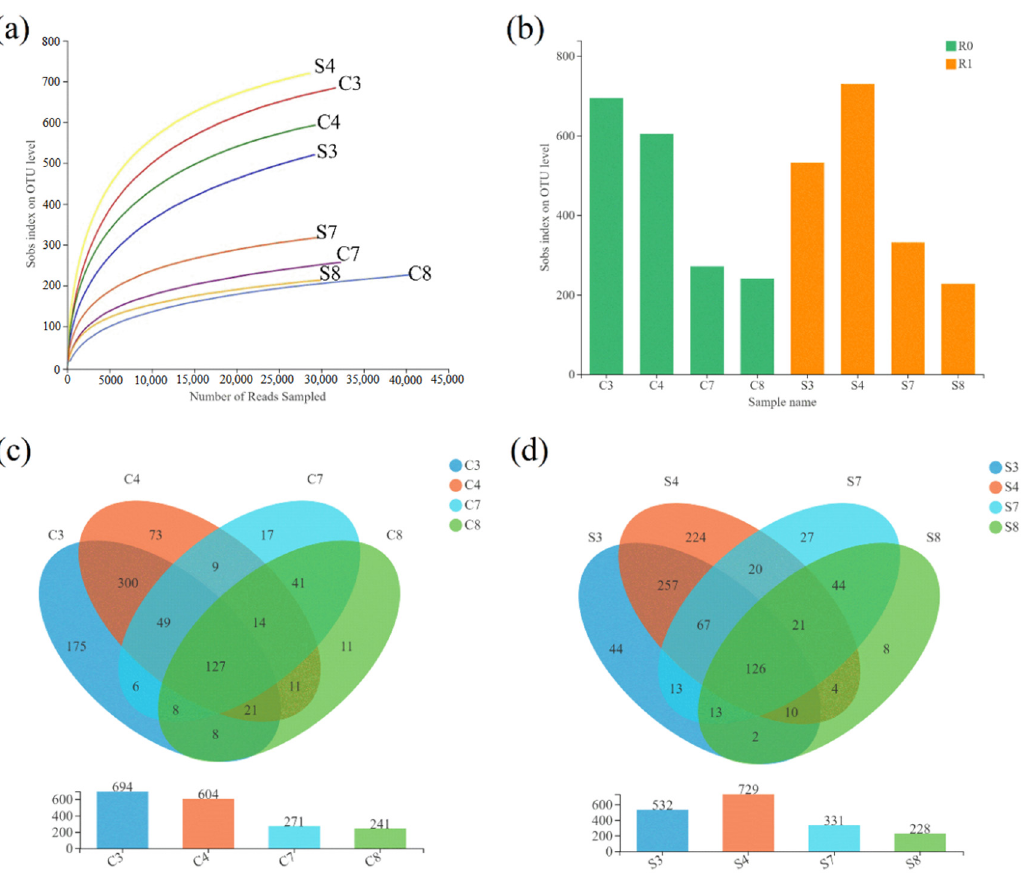
Figure 3. Microbial diversities of the eight samples. Rarefaction curves ( a ); alpha diversity estimators ( b ); Venn diagram of R0 ( c ); Venn diagram of R1 ( d ).